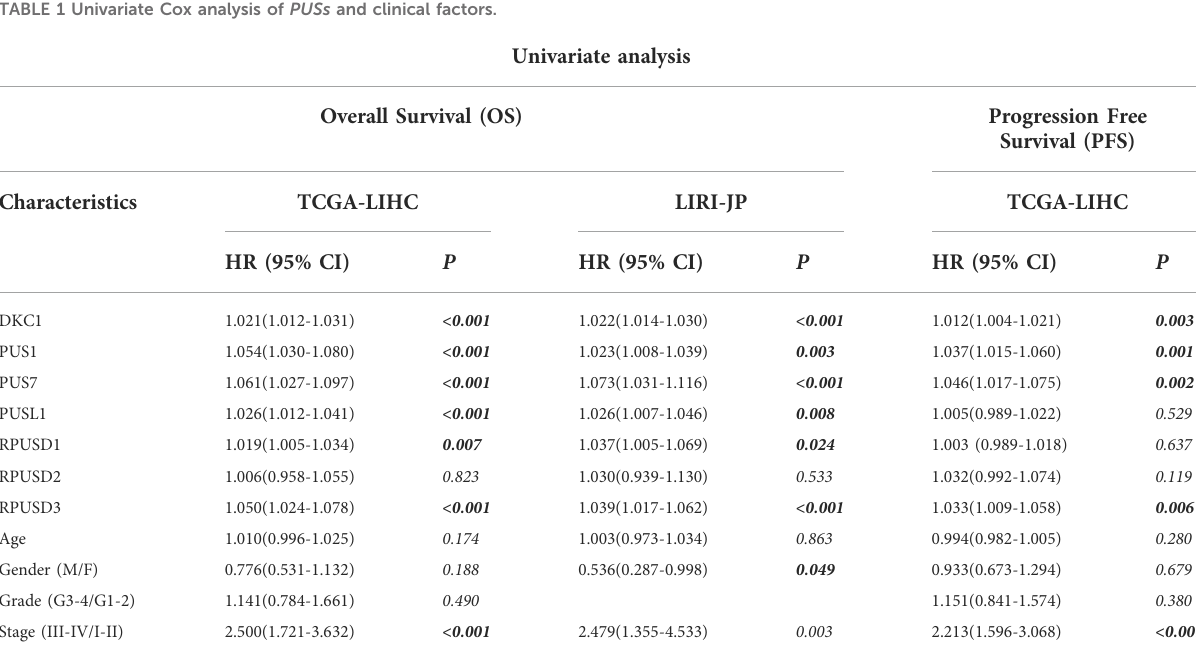
TABLE 1 Univariate Cox analysis of PUSs and clinical